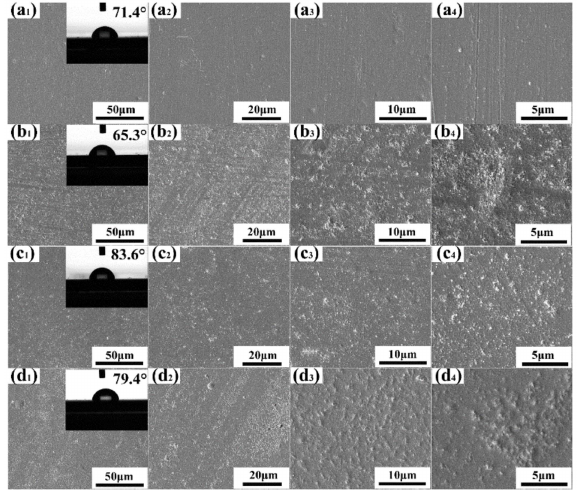
Figure 5. SEM images of surfaces and contact angle for ( a 1 – a 4 ) pure WPU, ( b 1 – b 4 ) 0.5 wt.% GO / WPU, ( c 1 – c 4 ) 0.5 wt.% PVSQ-GO / WPU, and ( d 1 – d 4 ) 1.0 wt.% PVSQ-GO / WPU